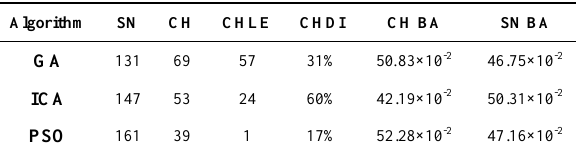
Table 2. WSN parameters.